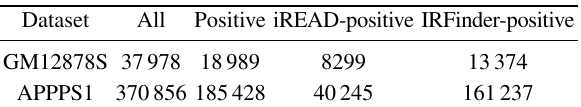
Table 2 Number of positive and negative samples in the training set.